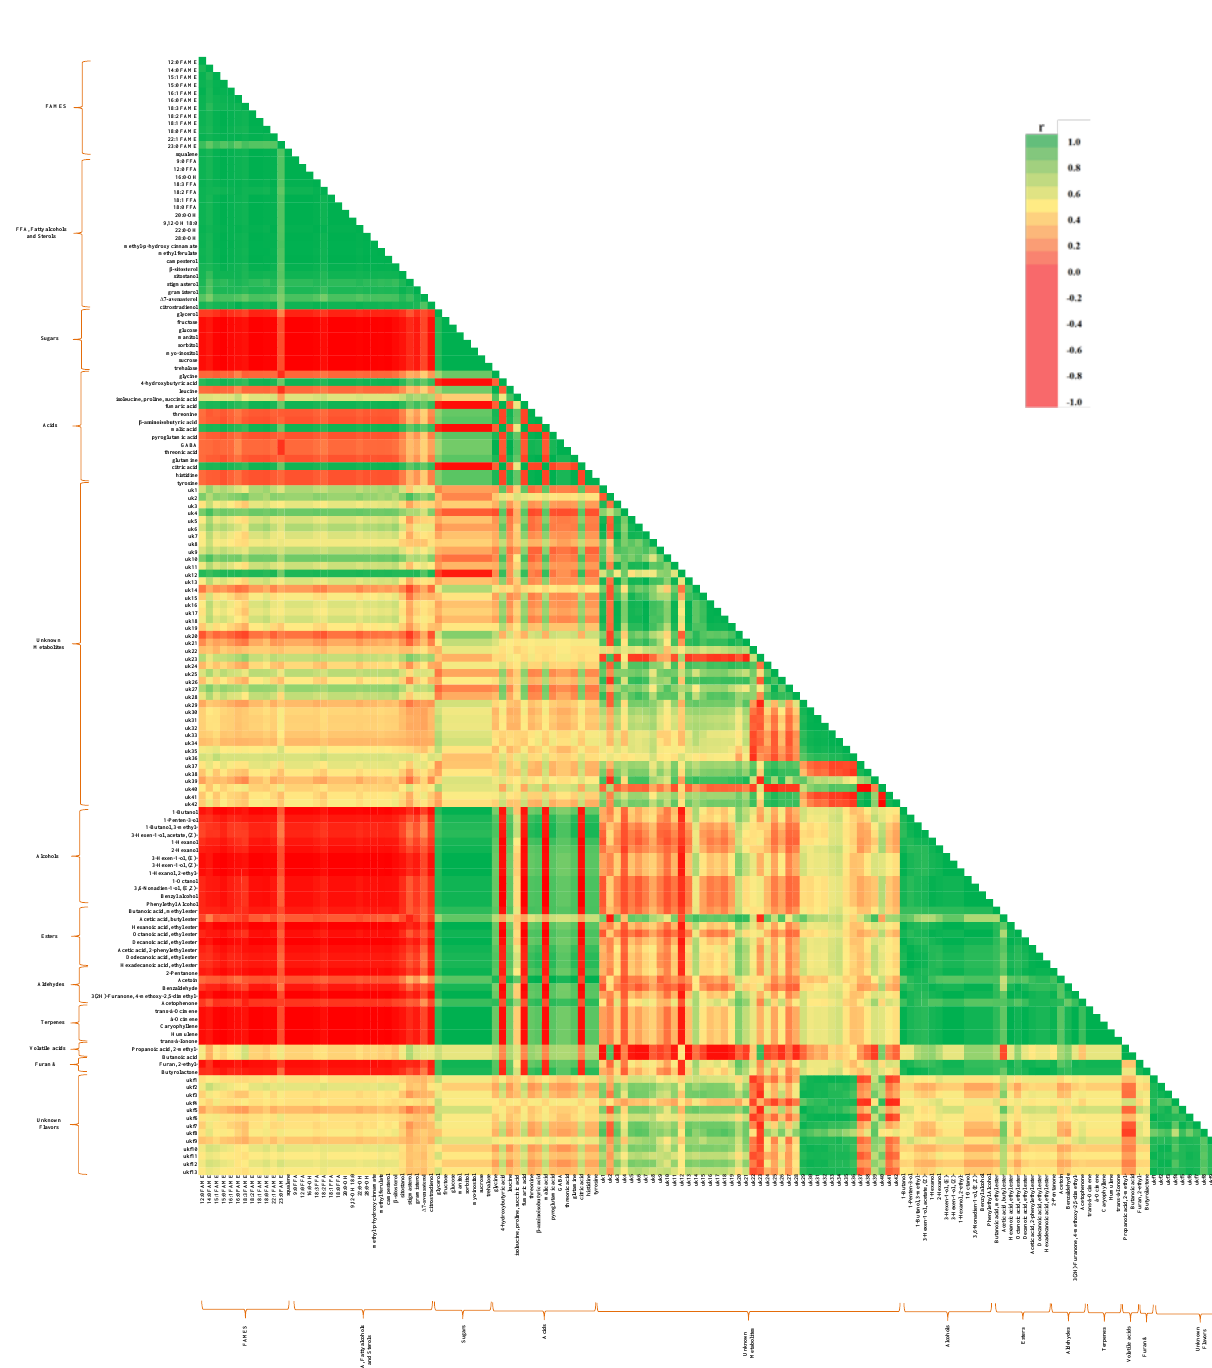
Figure 9. Pairwise triangular heat map correlation analysis among the metabolites and volatile organic compounds of mangoes at different ripening stages ( p ≤ 0.05). Positive correlations (r > 0.3) with green color scale (r > 0.7 indicates a strong positive correlation). Negative correlations (r < − 0.3) with red color scale (r < − 0.7 indicates a strong negative correlation).